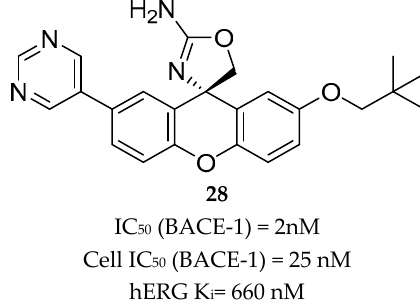
Figure 26. Spirocyclic aminooxazoline lead compound 28 .